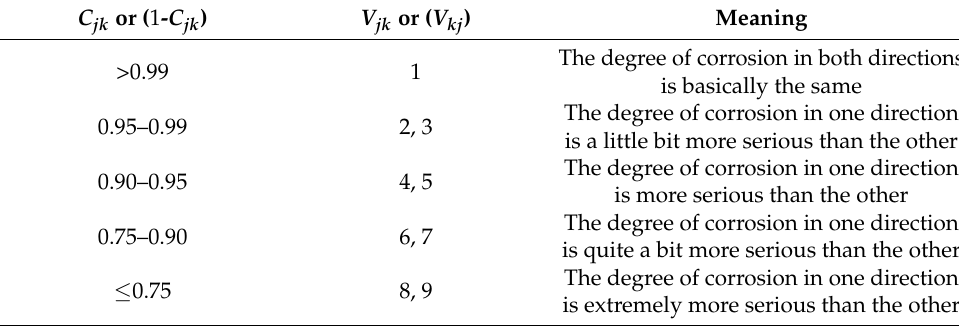
Table 1. Judgment matrix scale and its meaning.